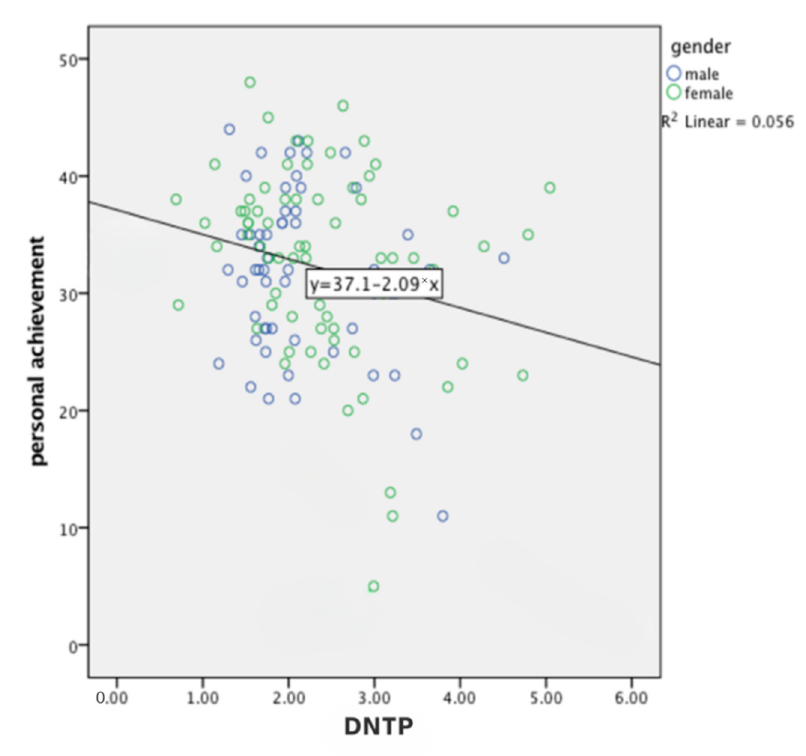
Figure 2. Linear regression analysis of DNTP and personal achievement.